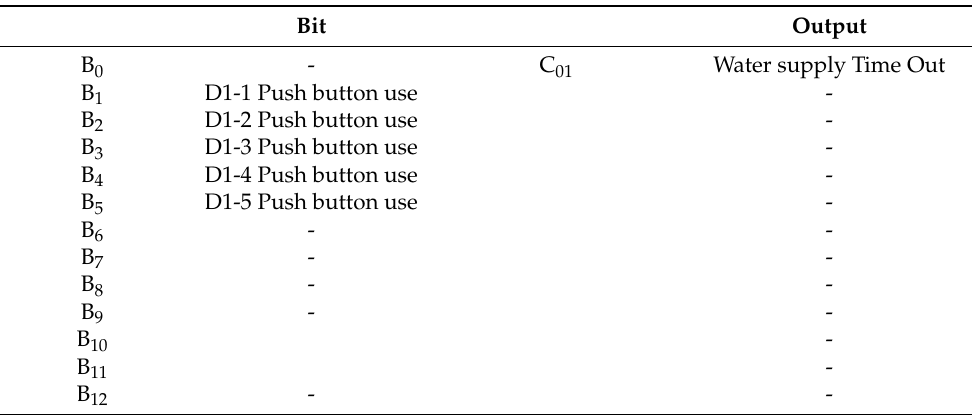
Table 4. Register